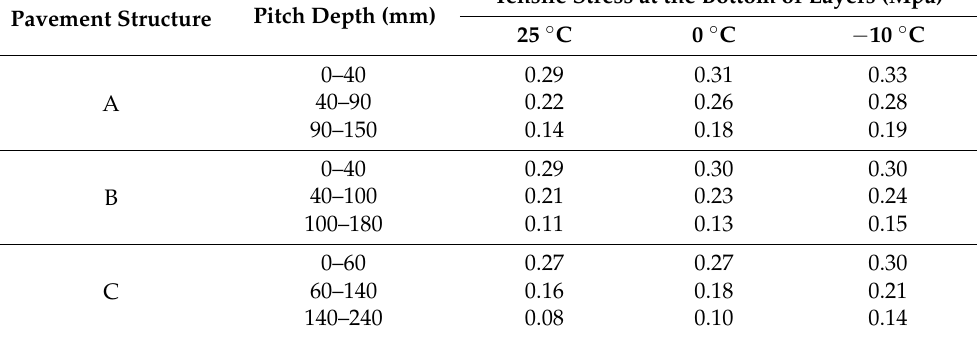
Table 6. Tensile stress at the bottom of each structure layer of the asphalt pavement with a semi- rigid